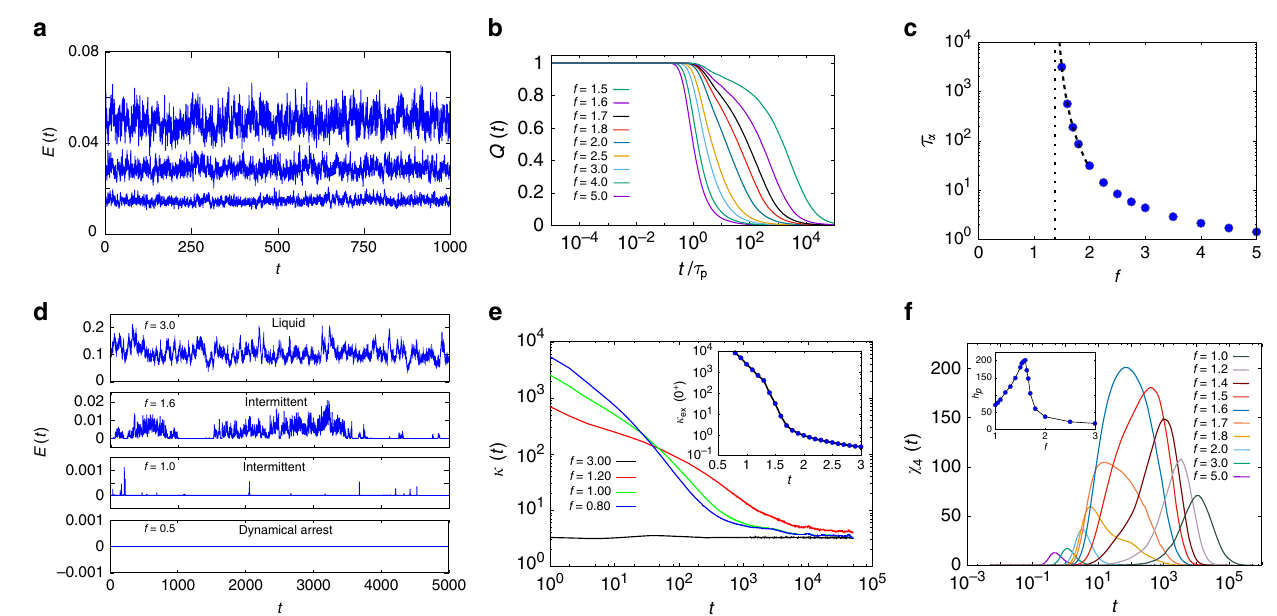
Fig. 2 Dynamical arrest and intermittency at low and intermediate τ p . a – c Low τ p = 1: a Kinetic-energy time series, E ( t ), at different f = 2.5, 2.0, and 1.5 (top to bottom), show regular fl uctuations; both the mean and the variance reduce with decreasing f . b Density fl uctuations, measured via the self-overlap function Q ( t ), relax more slowly as the activity f is reduced. c The slowness of the relaxation dynamics is measured by the α -relaxation time, τ α , extracted from Q ( t ), for each f . The measured τ α versus f is fi tted (dashed line) using a diverging power-law form, which traces out the limit of dynamical arrest f c ( τ p ) (dotted line) for small τ p in Fig. 1. d – f Intermediate τ p = 10 4 : d Kinetic-energy time series as f is lowered, shows Gaussian fl uctuations at high f > f * , intermittent bursts and quiescence and fi nally dynamical arrest when f ≤ f c . e Intermittency is characterised by the behaviour of the time-dependent . We see that in the small t end of this log plot, κ ( t ) increases linearly as t decreases, and kurtosis of the kinetic energy time series, κ ð t Þ ¼ hð E ð t 0 þ t Þ(cid:3) E ð t 0 ÞÞ 4 i hð E ð t 0 þ t Þ(cid:3) E ð t 0 ÞÞ 2 i 2 should therefore diverge, when extrapolated to t → 0. The dynamical order parameter is measured from the value of κ ( t ) at the earliest time that we can evaluate, i.e., t = 0 + . (Inset) Variation of the dynamical order parameter, the excess kurtosis, κ ex (0 + ) with f . We use the point of in fl ection of this curve to determine the phase boundary to the intermittent phase. f The fl uctuation χ 4 ( t ) = 〈 Q 2 ( t ) 〉 − 〈 Q ( t ) 〉 2 , shows a peak at a time t for different values of f . (inset) At a fi xed τ p = 10 4 , the value of the peak height h p increases sharply as f approaches f * ( τ p ) from above, then reduces again. The value of f at which h p has a maximum, for different values of τ p , also marks the boundary between the liquid and the intermittent phase (see Fig.